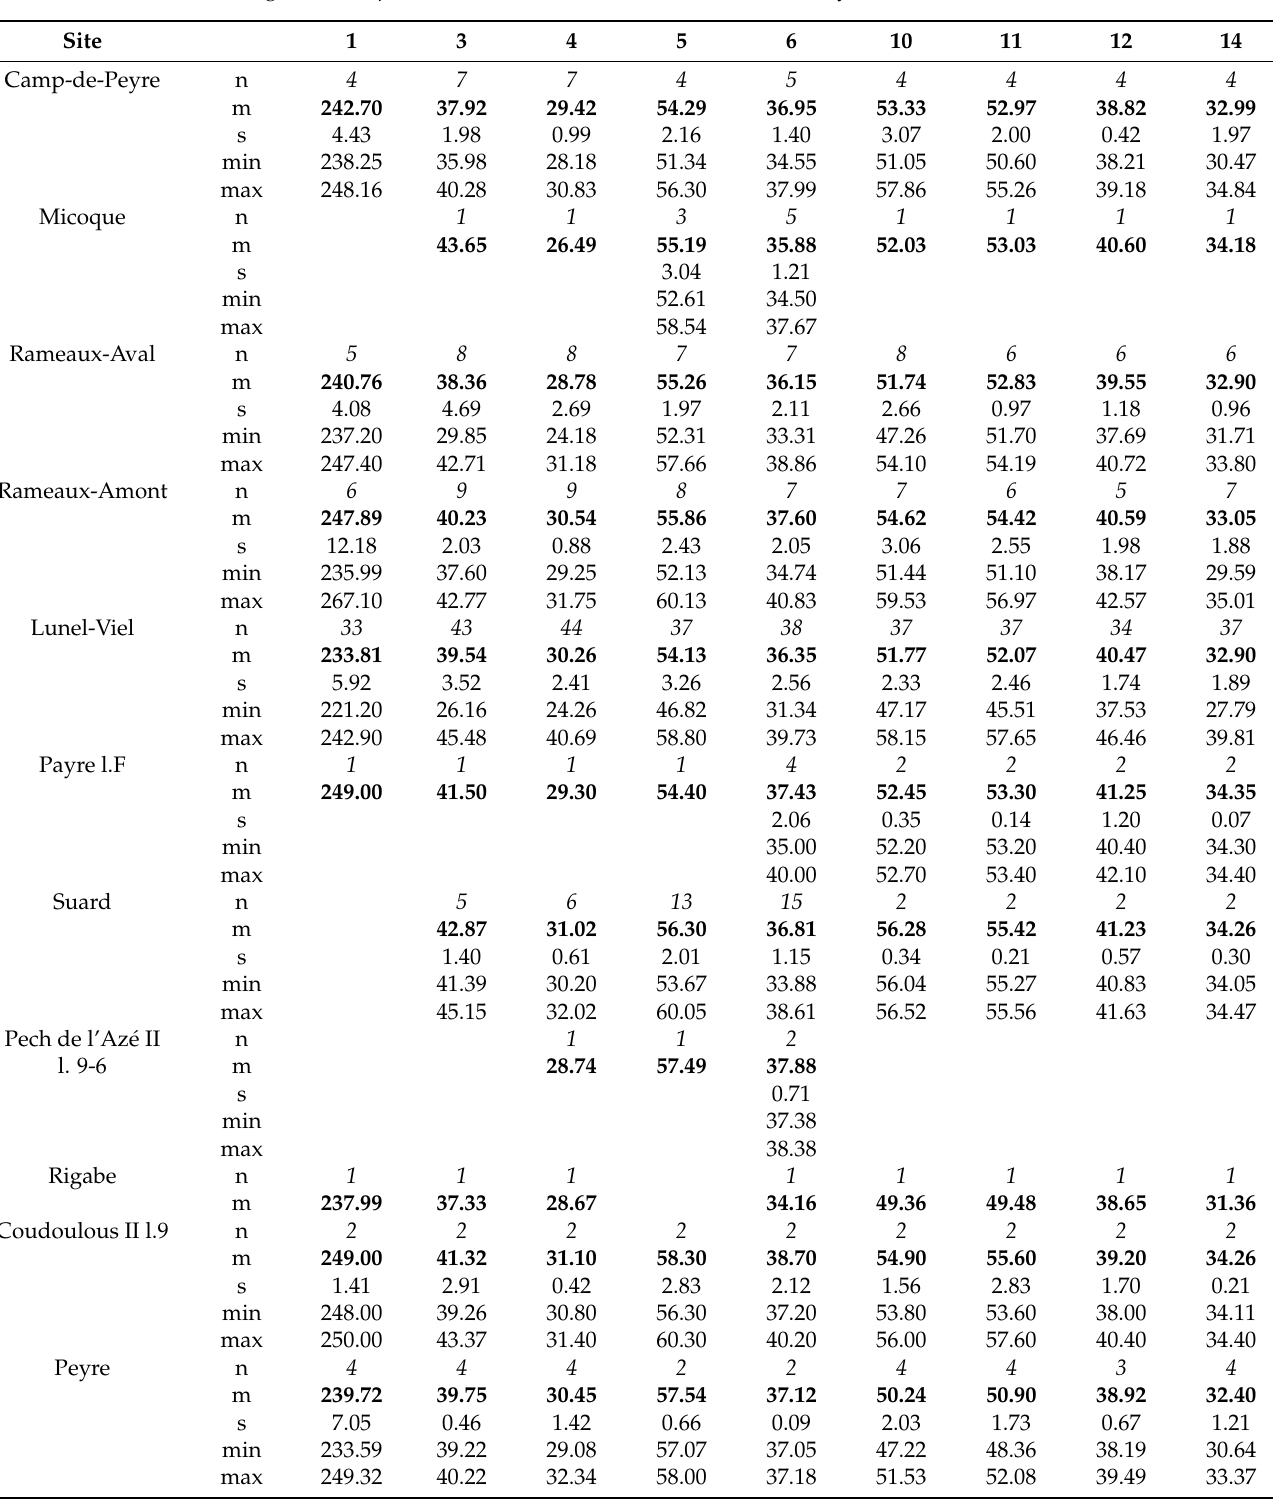
Table 3. Measurements in millimetres of the third metacarpals of horses from the caballoid lineage. 1: Maximal length; 3: Breadth at the middle of the diaphysis; 4: Depth of the diaphysis at the same level; 5: Proximal breadth; 6: Proximal depth; 10: Distal supra-articular breadth; 11: Distal articular breadth; 12: Depth of the sagittal crest; 14: Greatest depth of the medial condyle (measurements from V. Eisenmann [76]). n = number of specimens; m = mean; s = standard deviation; min-max: minimal and maximal values. Camp-de-Peyre: E. m. campdepeyri ; La Micoque: E. mosbachensis ; Rameaux-Aval and Amont: E. mosbachensis ; Lunel-Viel: E. m. palustris ; Payre l.F: E. mosbachensis ; Suard: E. caballus piveteaui ; Pech de l’Az é II l.9-6: E. mosbachensis ; Rigabe: E. m. palustris ; Coudoulous II l.9: E. mosbachensis ; Peyre: E. caballus